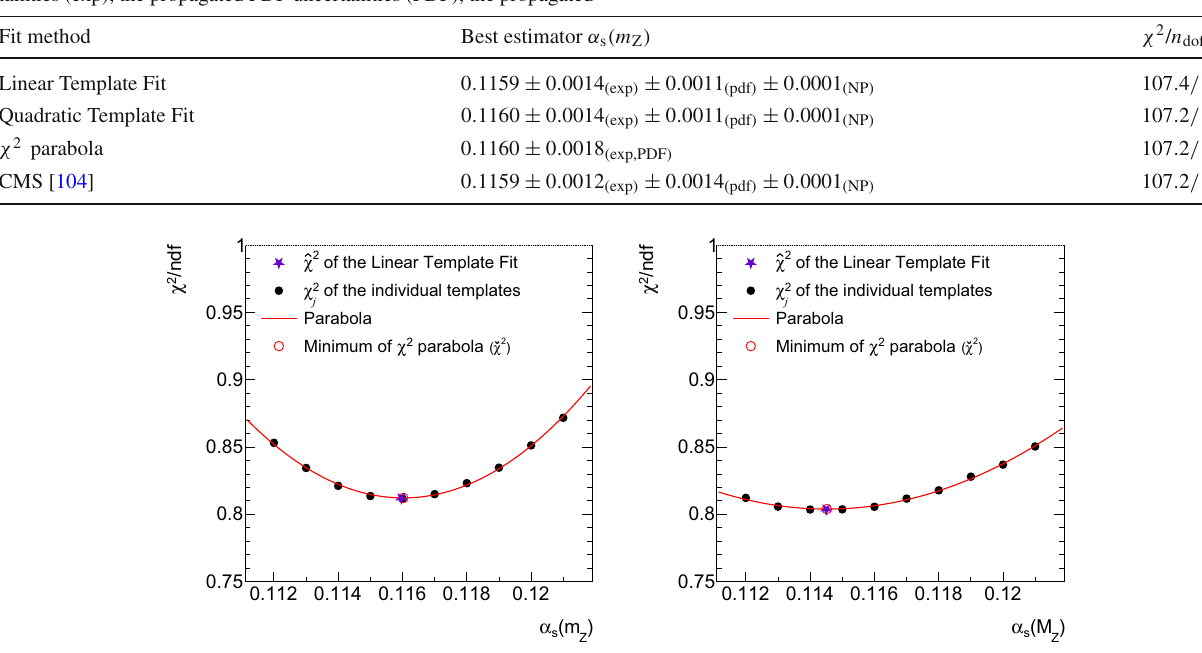
Fig. 8 Visualization of the templates, the data, and the implicit linearization of the model in some selected bins of the Linear Template Fit to the CMS inclusive jet cross sections. More details are given in the caption of Fig. 1 Table 1 Results from a Linear Template Fit of NLO pQCD predic- tions using the MSTW PDF set to CMS inclusive jet cross section data. The results are compared with the Quadratic Template Fit and to the analytic calculation of the minimum of the χ 2 parabola, and to the pub- lished results by the CMS collaboration in the last row. Shown are the best estimators for α s ( m Z ) , the quadratic sum of all experimental uncer- tainties (exp), the propagated PDF uncertainties (PDF), the propagated